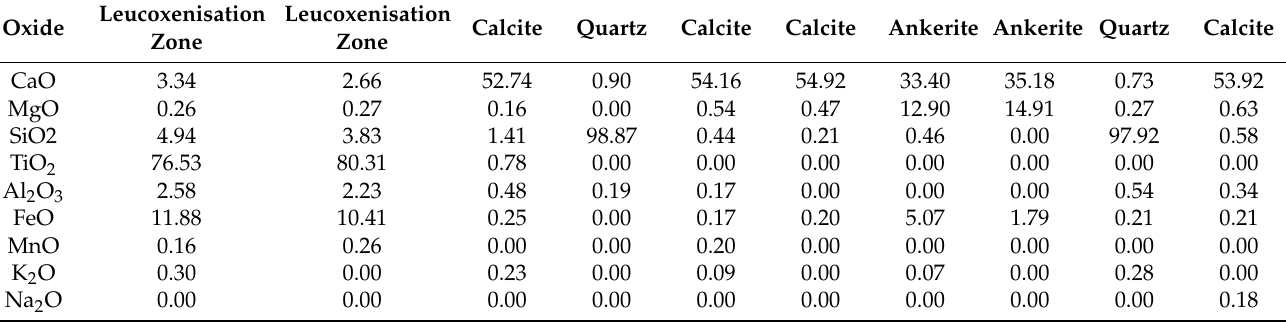
Table 2. Chemical composition of minerals (according to electron microprobe analyses) of dolomitic limestone samples taken from the surface of the mine walls, wt. %.